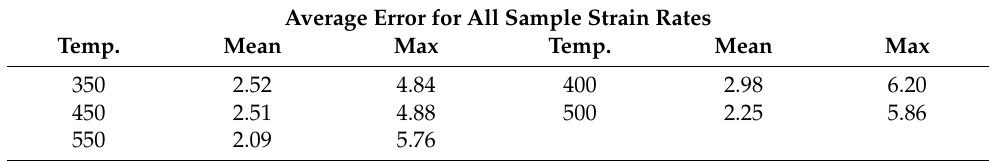
Figure 6. Experimental CLSCs and their predictions by the RFCs–AFCs: ( a ) 0.1 s − 1 , ( b ) 1 s − 1 , ( c ) 5 s − 1 , ( d ) 10 s − 1 , and ( e ) 20 s − 1 . Table 4. Error analysis of the CLSCs predicted by RFCs–AFCs. Average Error for All Sample Strain Rates Temp. Mean Max